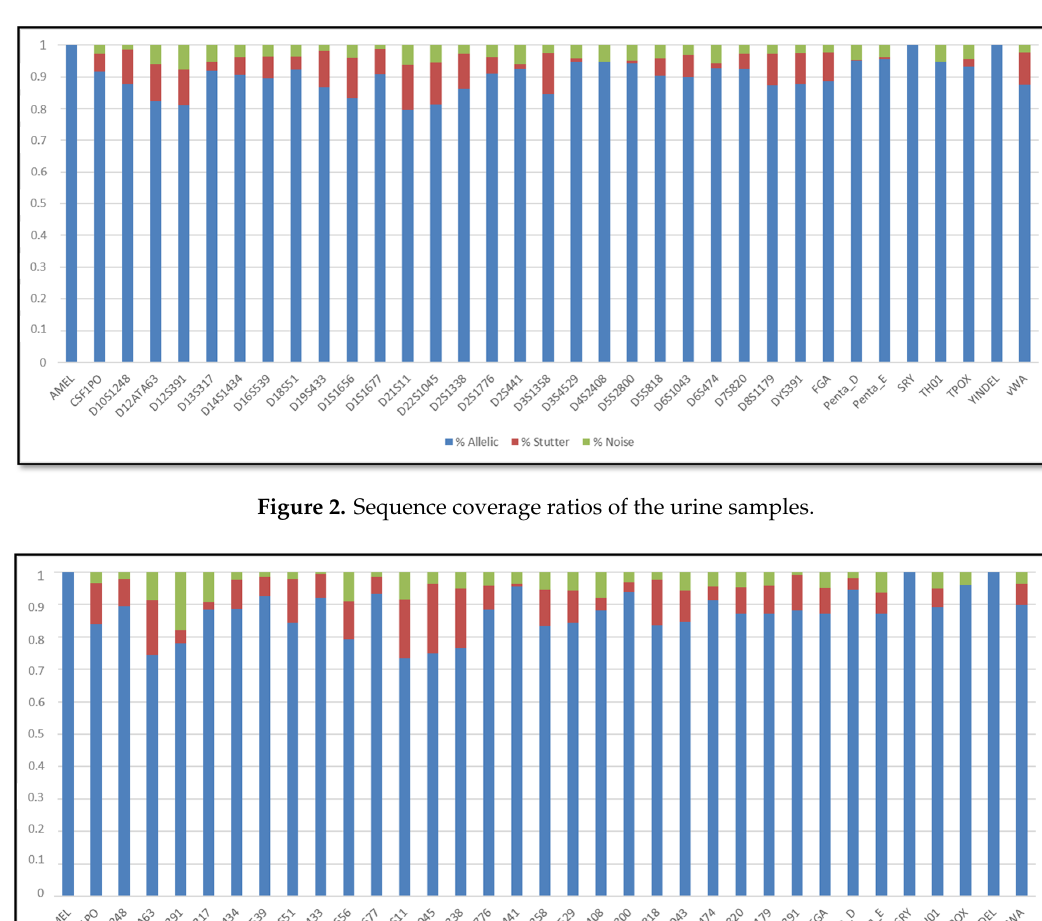
Figure 1. Sequence coverage ratios of the buccal swab samples.